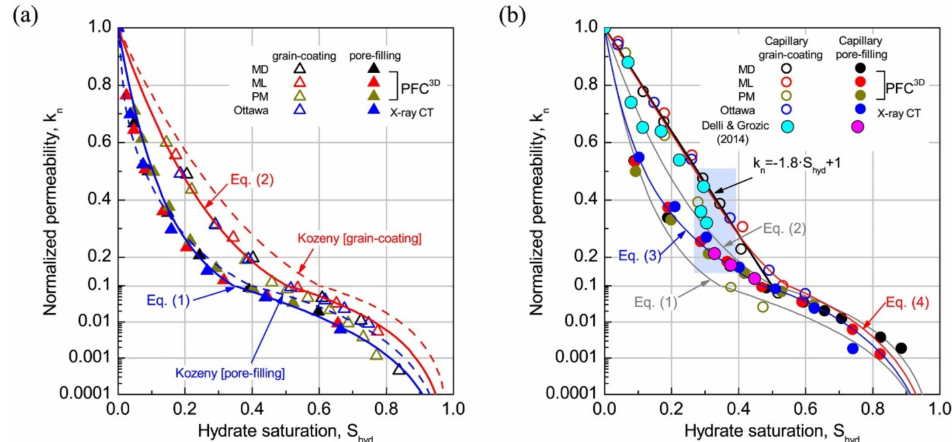
Figure 7. Normalized permeability calculated by lattice Boltzmann flow simulation that ( a ) ignores capillary effects and ( b ) considers capillary effects. Reprinted with permission from Ref. [53]. Copyright 2022 American Geophysical Union. Note: Please refer to the original literature for the experimental data points and equations shown in the figure.